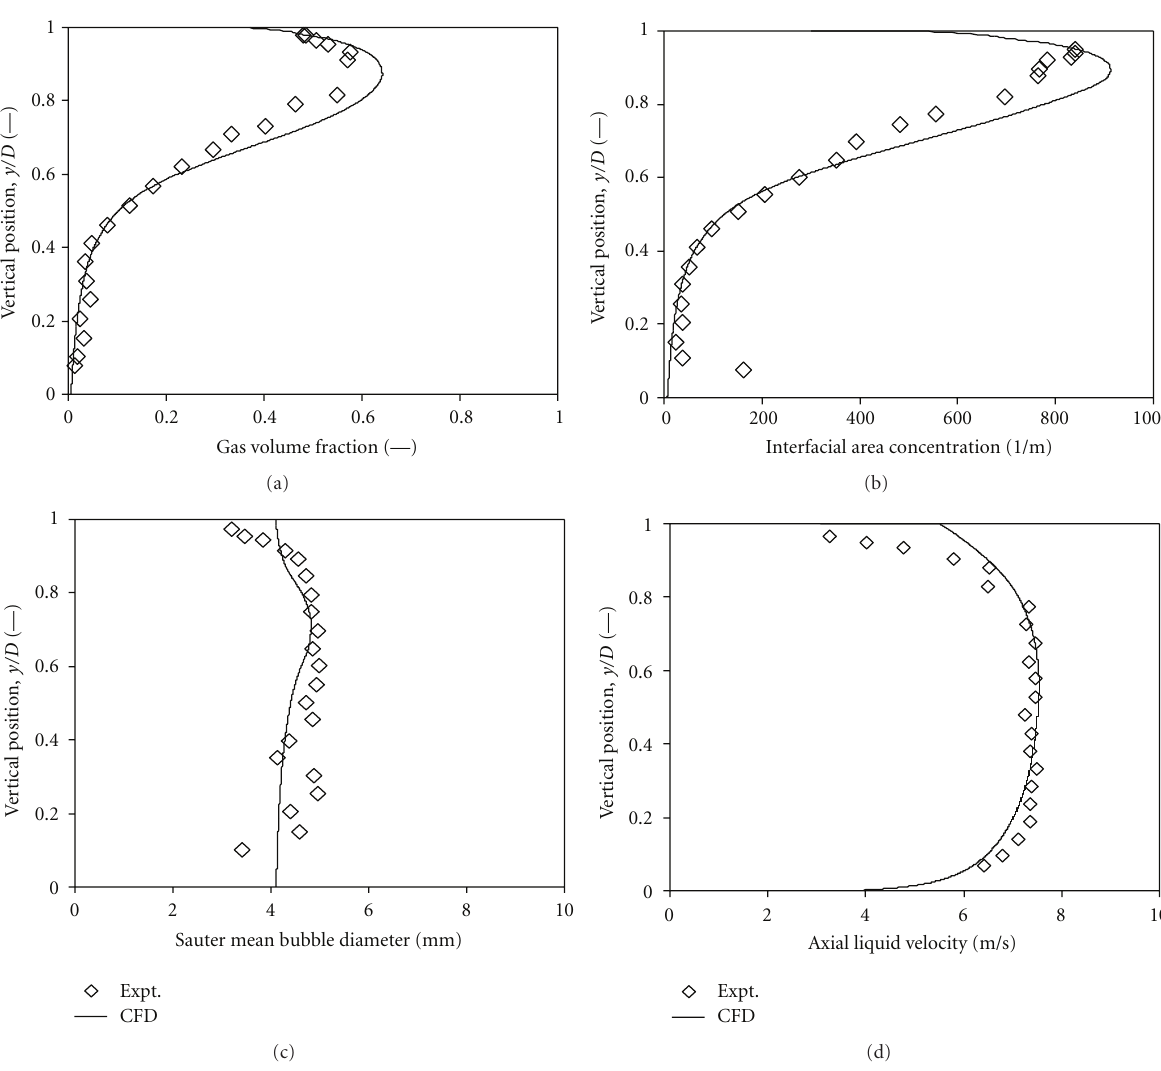
Figure 6: Comparison of predicted and experimental data of Kocamustafaogullari and Wang [17] for superficial gas velocity of 1.34 m/s, superficial liquid velocity of 5.1 m/s, and volume fraction of 0.204; (a) gas volume fraction, (b) interfacial area concentration, (c) Sauter mean bubble diameter, and (d) axial liquid